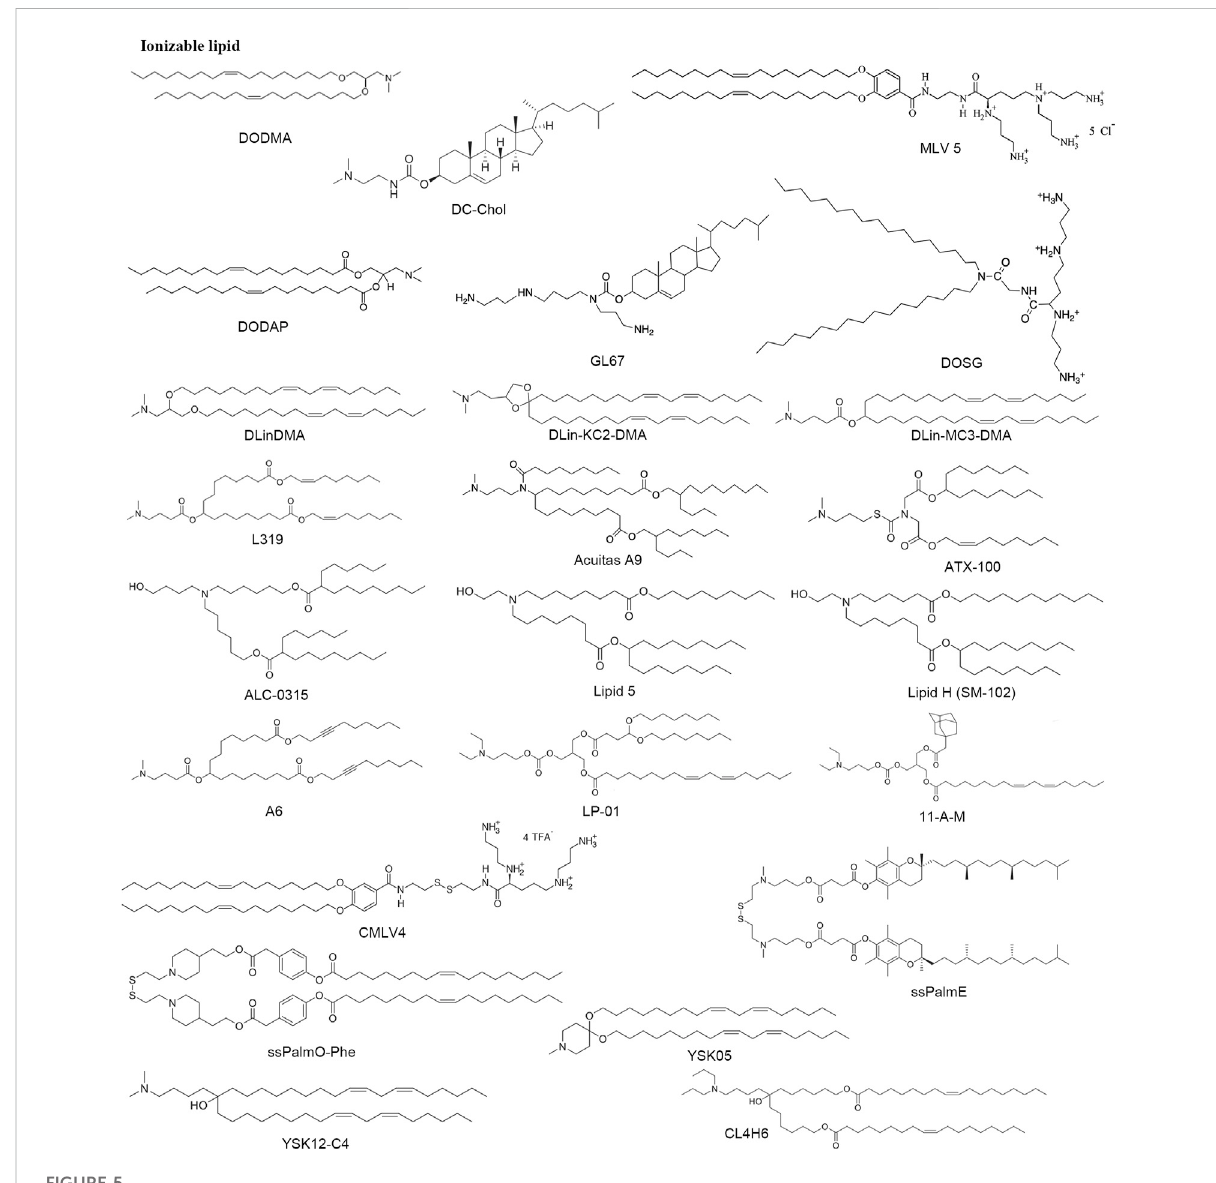
FIGURE 5 Structure of some typical ionizable